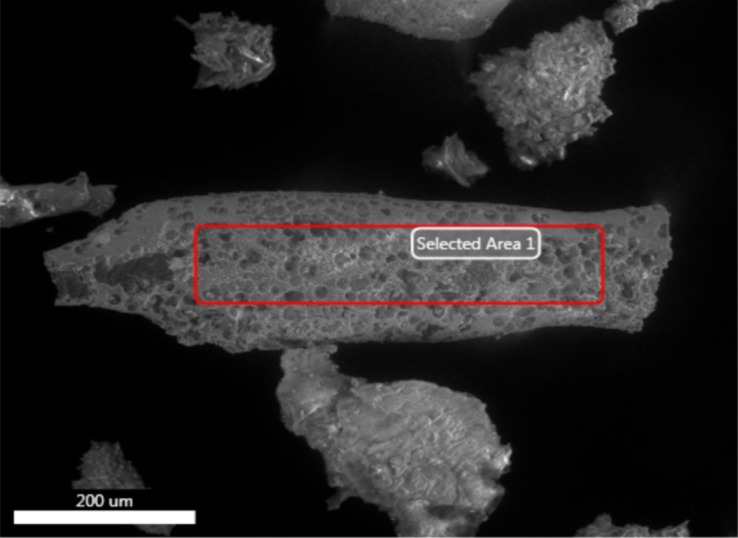
Electron image of another vessel from demineralised Late Cretaceous Centrosaurus bone area C.